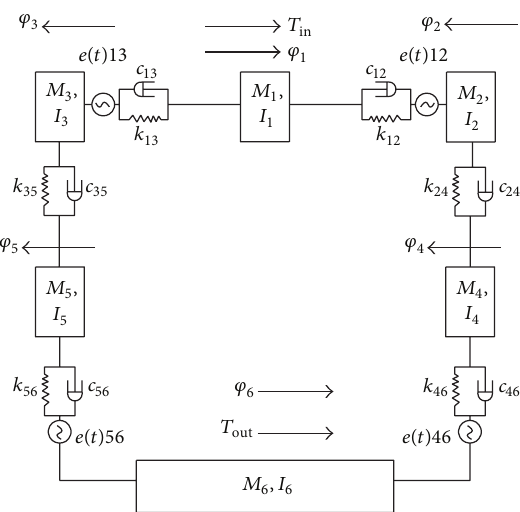
Figure 2: Schematic of mechanical structure